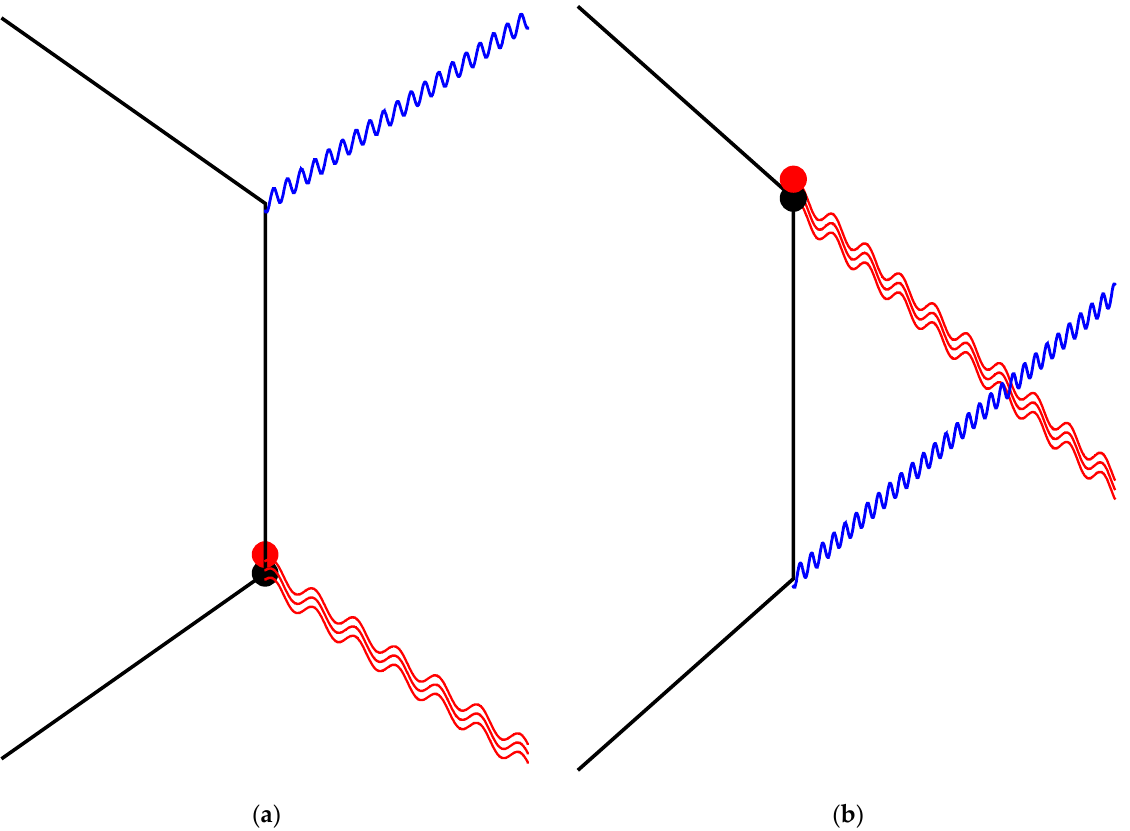
Figure 2. Illustrates the two terms of the transition matrix elements (51) of the quantized strong-field Kramers–Heisenberg formula. The continuous black lines correspond to exact atomic electron initial, final and intermediate states. The red wavy lines symbolize the photon ansorption of the incoming strong laser field, and the blue wavy line refers to the outgoing harmonic radiation. The nonlinear interaction is condensed to the multiphoton effective potential V ˆ α , which has been defined in Equation (34), and discussed in details in Section 3. In the figure this potential is symbolized by a pair of small discs, one being black (this refers to the original atomic potential), and the other disc is red-coloured (which refers to its dressing by the laser field); ( a ) The space-time diagram corresponding to the resonant term 0,1 A , Equation (52); ( b ) is the space-time diagram corresponding to the matrix element 0,1 B of Equation (53).